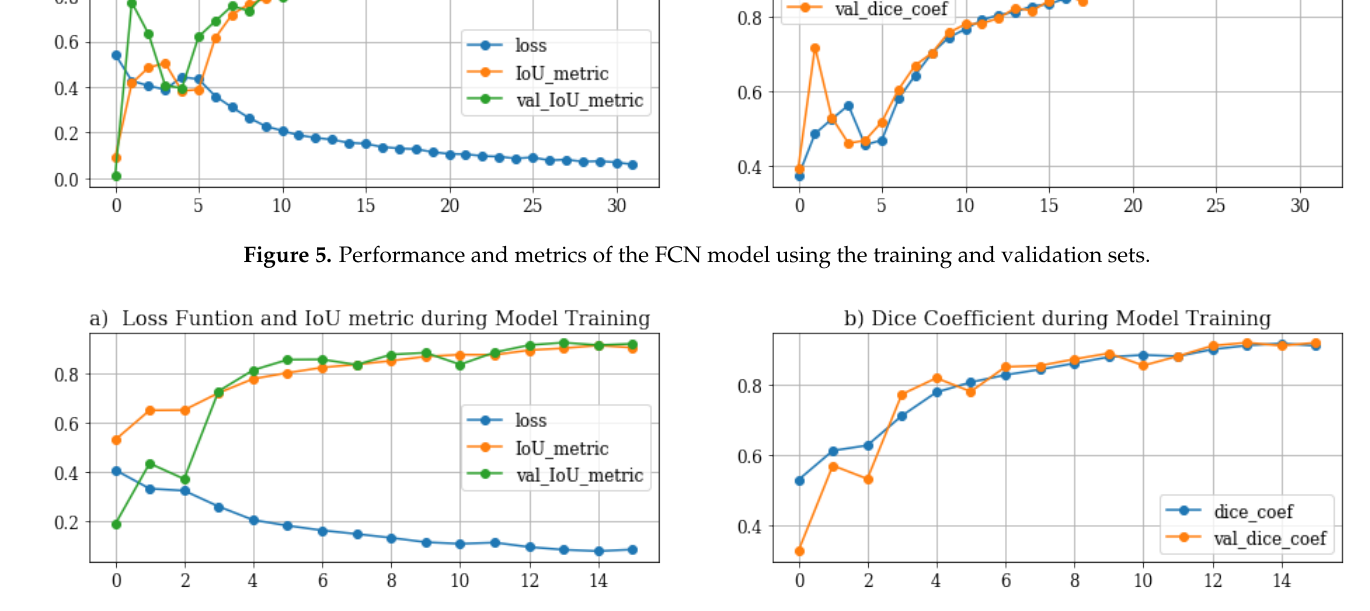
Figure 6. Performance and metrics of the U-net model obtained using the training and validation